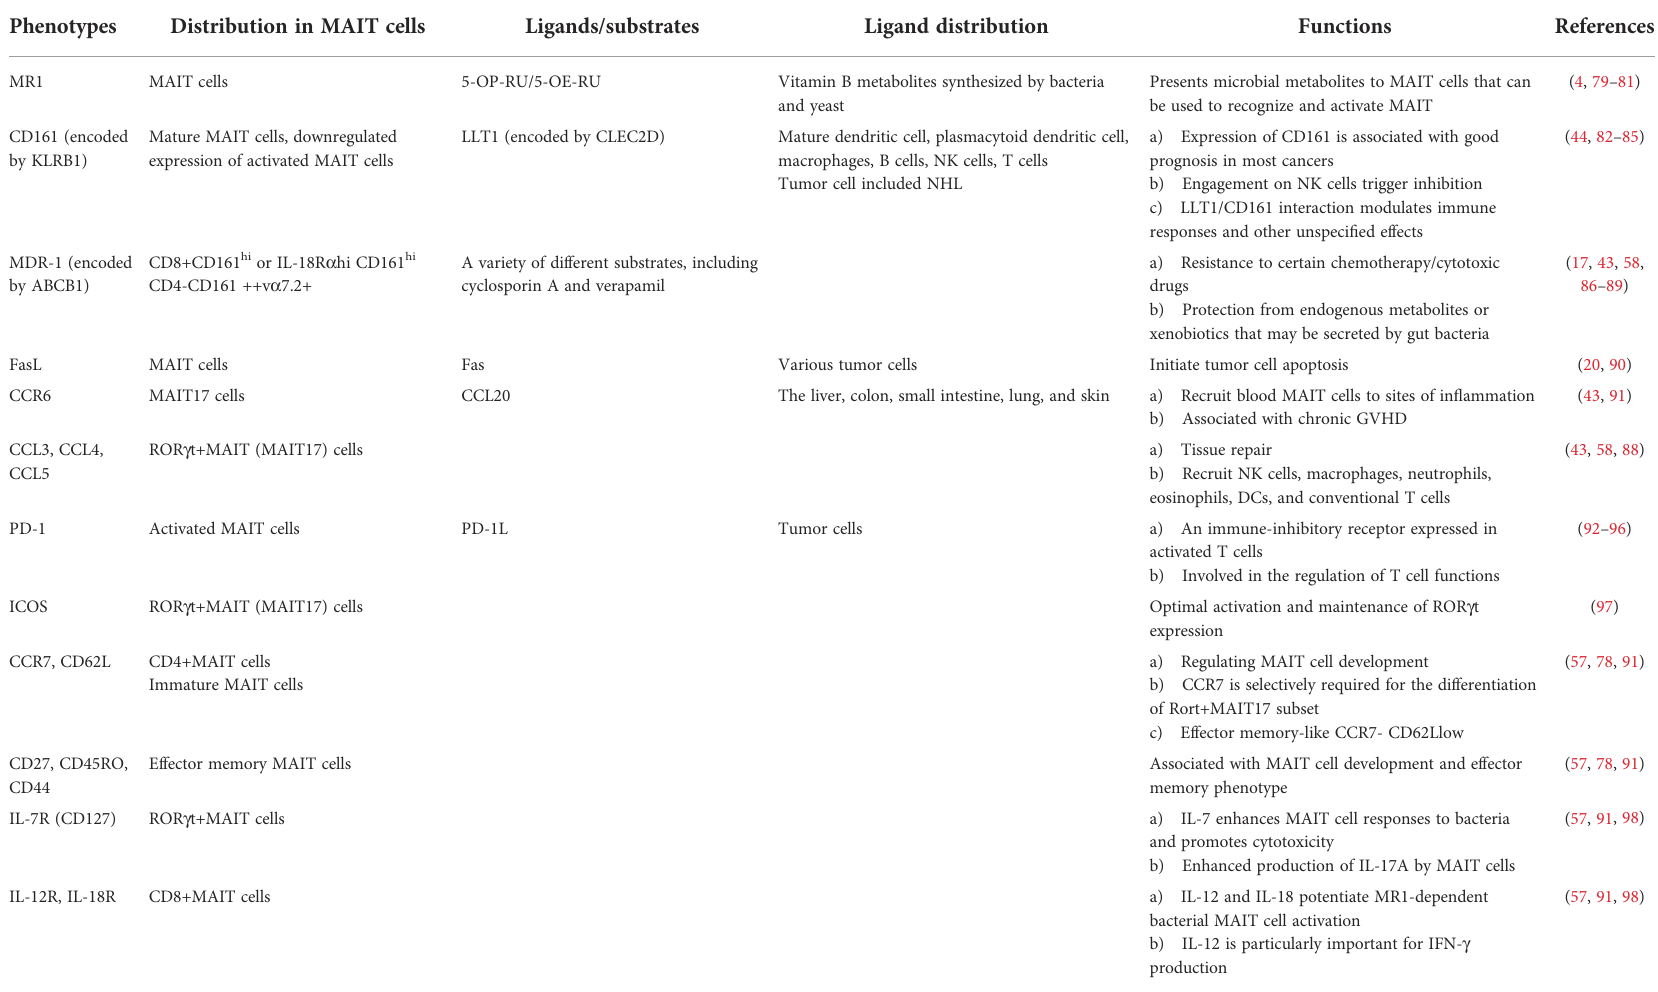
TABLE 2 Major effector phenotypes of MAIT